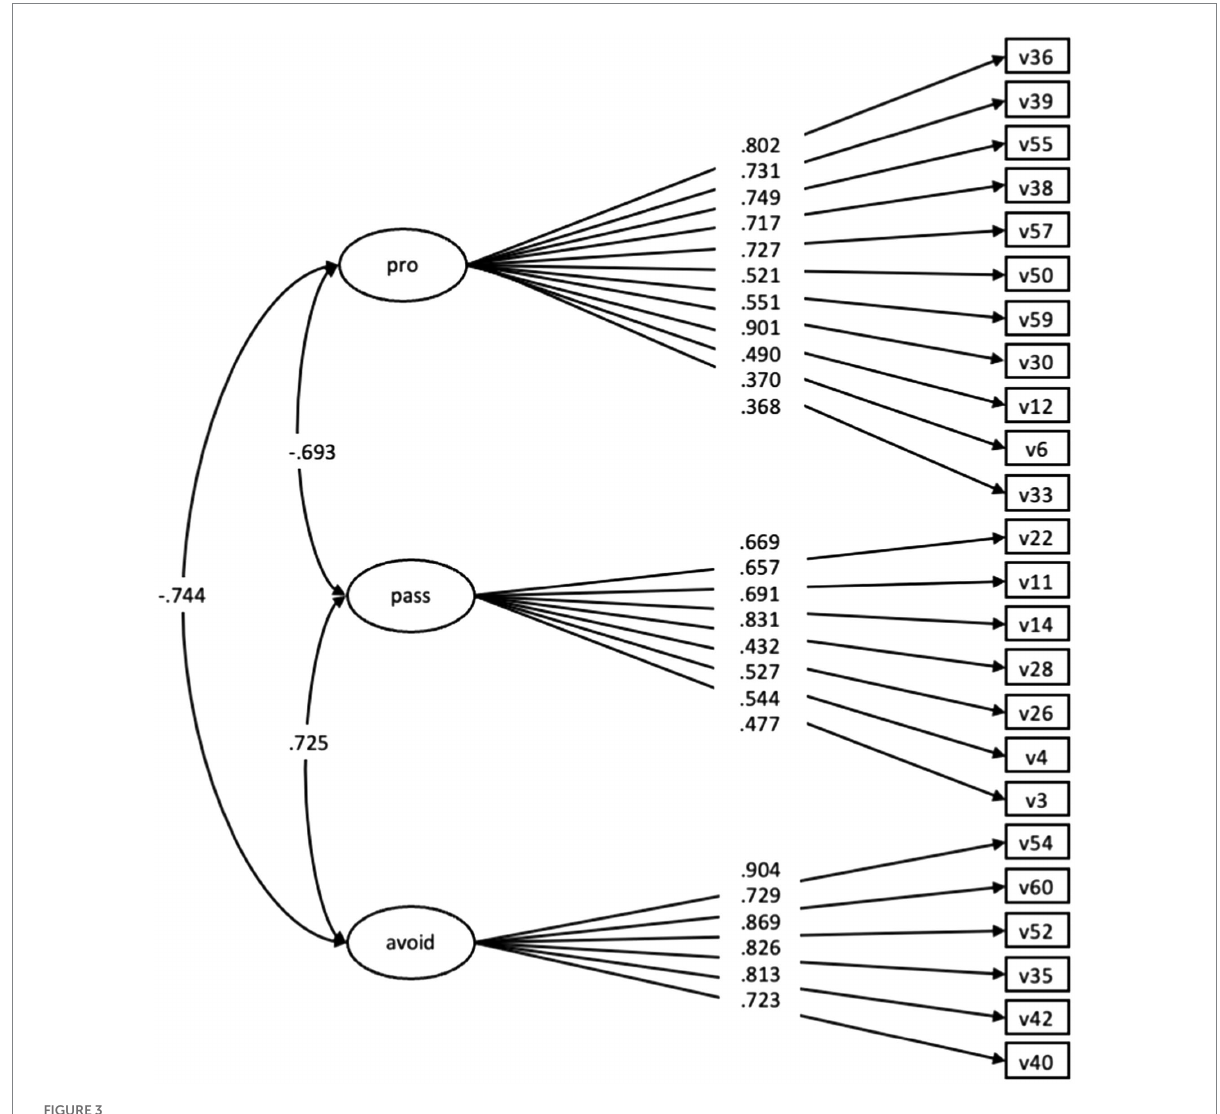
FIGURE 3 Mplus 8.6 software outputs of the confirmatory factor analysis (see